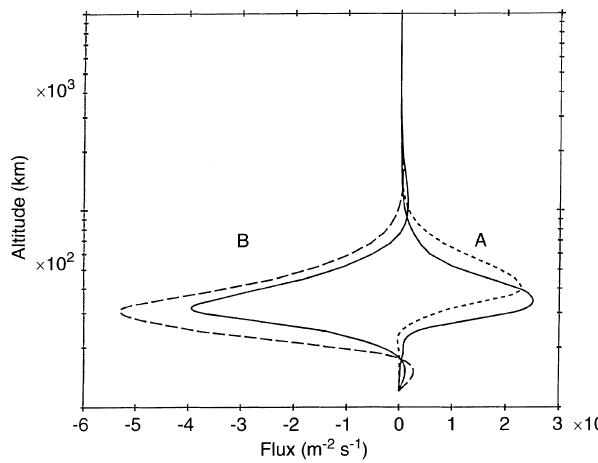
Fig. 5. Model O (cid:135) flux values during the enhanced velocity event at 9:23 UT (- - -), point A on path, and at 9:53 UT (– –), point B on the path. Fluxes at these points with no enhanced velocity are shown for comparison (—), Positive flux is upwards , negative values represent